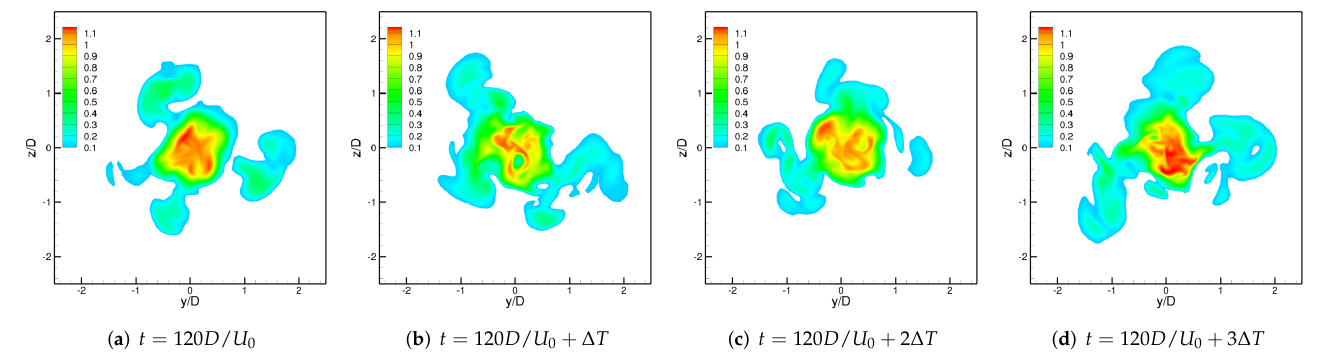
Figure 15. Contours of an instantaneous axial velocity U x / U 0 at the plane perpendicular to the jet axis x / D = 9 for the case E − Cyl − Ti 0.1 .